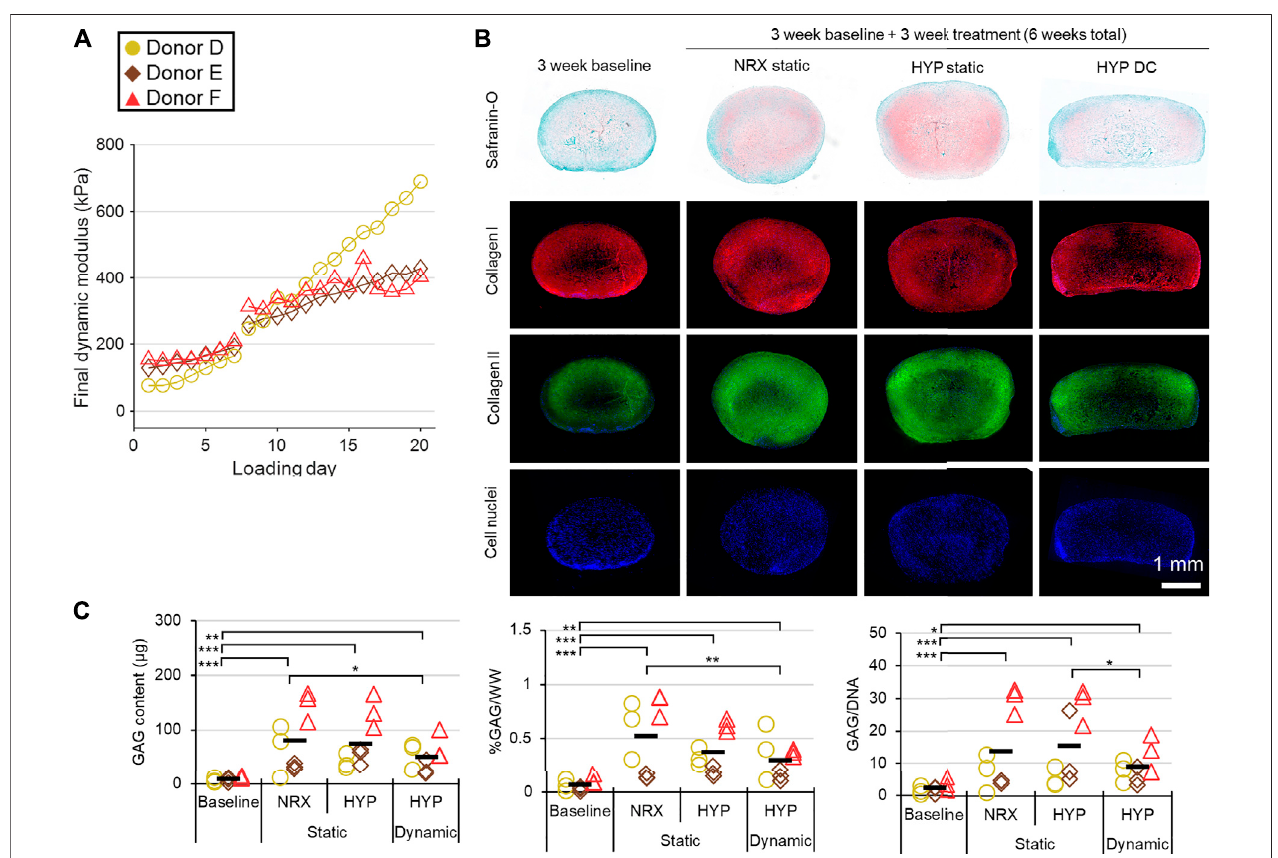
FIGURE 7 | Experiment III: Mechanical and protein outcomes from 3 weeks of mechano-hypoxia conditioning after a 3-weeks baseline pre-culture period (up to a 6-weeks total culture duration). (A) Mechanical performance over time for each donor. The strain offset was increased from 30 to 35% on loading day 8, resulting in a jump in properties. For clarity, properties for only 1 of four loading events is presented per day. (B) Representative tissue matrix phenotypes. (C) Biochemistry. GAG, glycosaminoglycans; WW, wet weight. *: p < 0.05, **: p < 0.01, ***: p < 0.001.